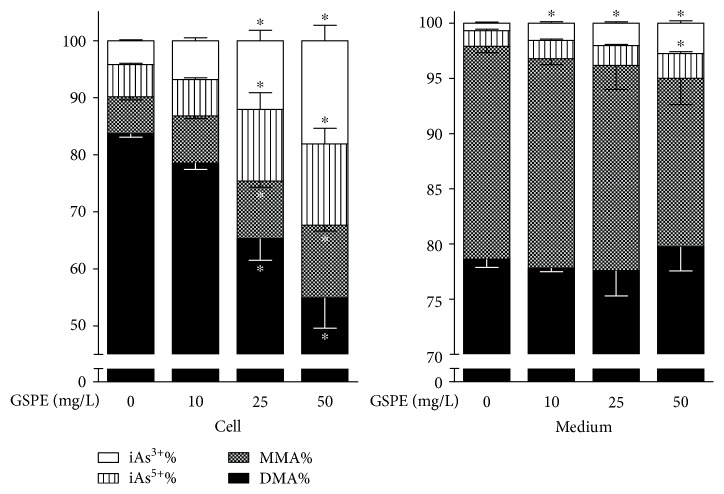
Proportion of arsenic methylated metabolites in cells and medium (mean ± SD, n = 3). The cells were treated with arsenic (25 μM) and grape seed procyanidin extract (GSPE; 10, 25, and 50 mg/L) for 24 h. ∗
P < 0.05 compared with the GSPE untreated group. Compared with the GSPE untreated group, 25 and 50 mg/L GSPE reduced the proportion of iAs3+ and increased the proportion of iAs5+, MMA, and DMA in cells. Similarly, treatment with GSPE for 24 h increased the proportion of DMA in medium compared with the untreated group.